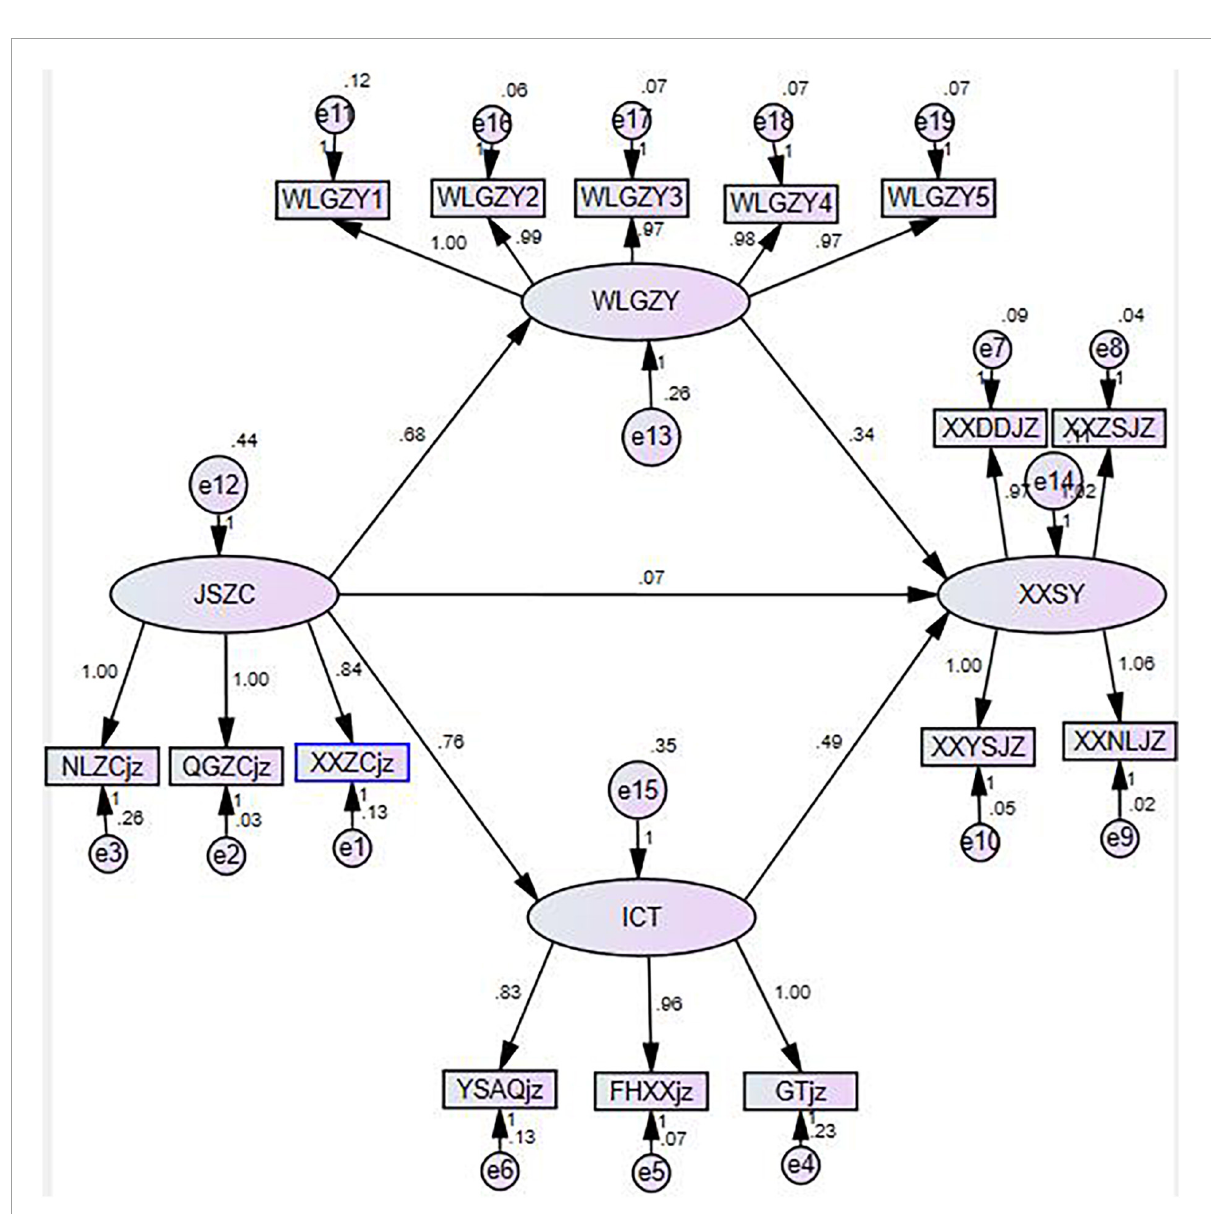
FIGURE2 Mediating model diagram of network perceived usefulness and ICT